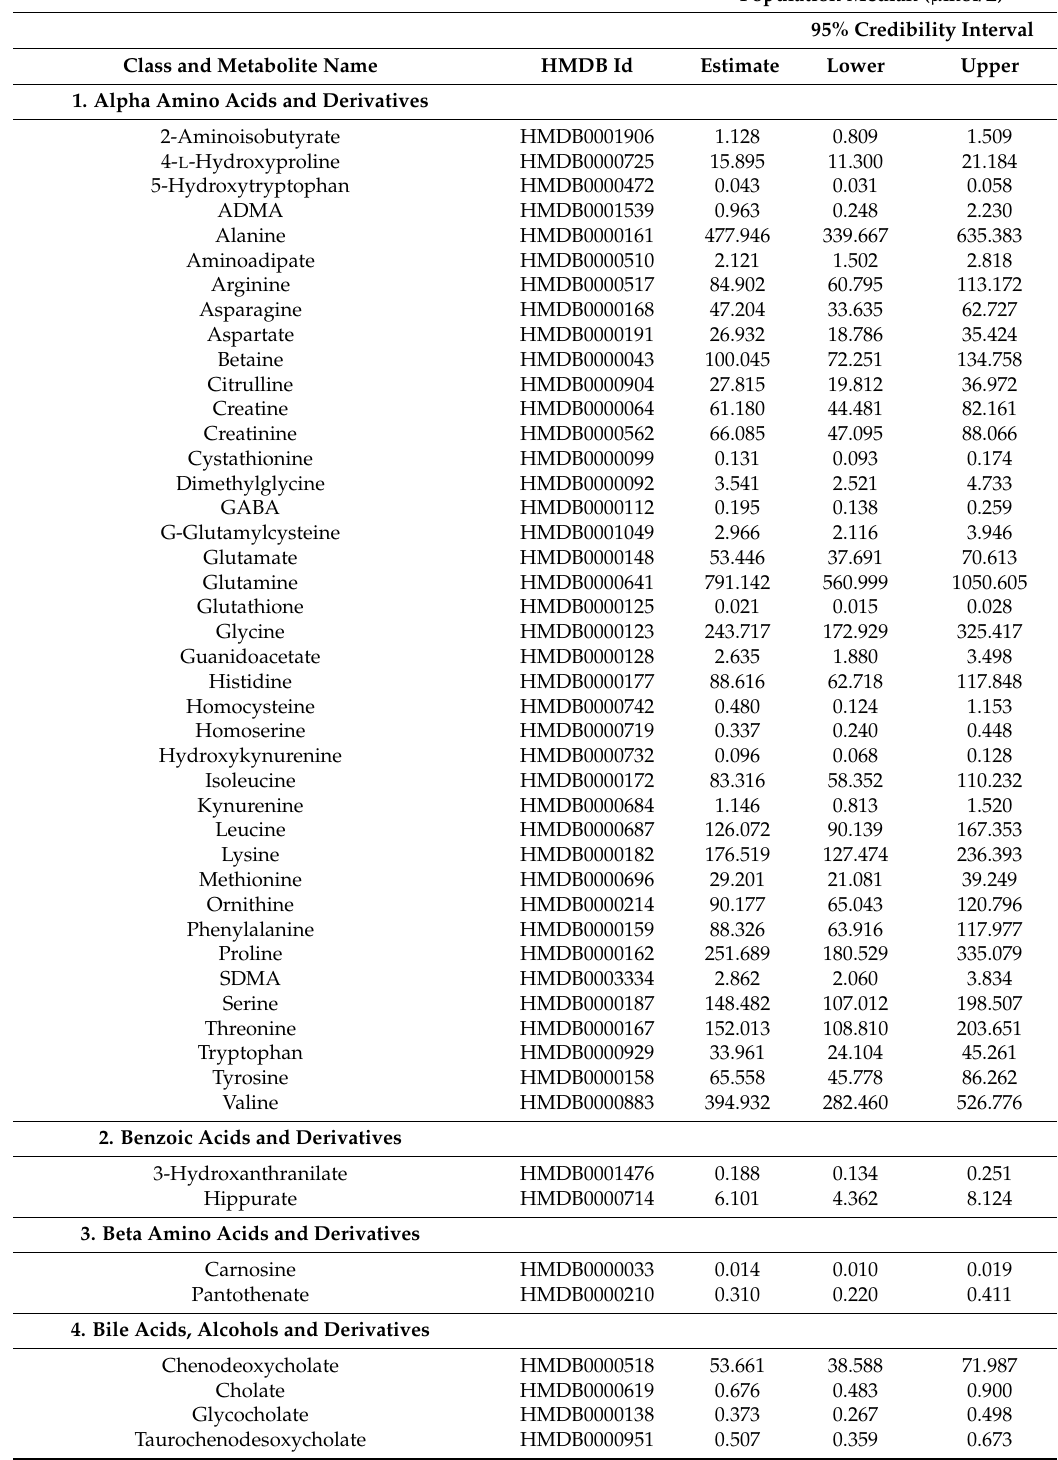
Table 1. Median concentration levels ( µ mol/L) measured in pooled healthy adult serum